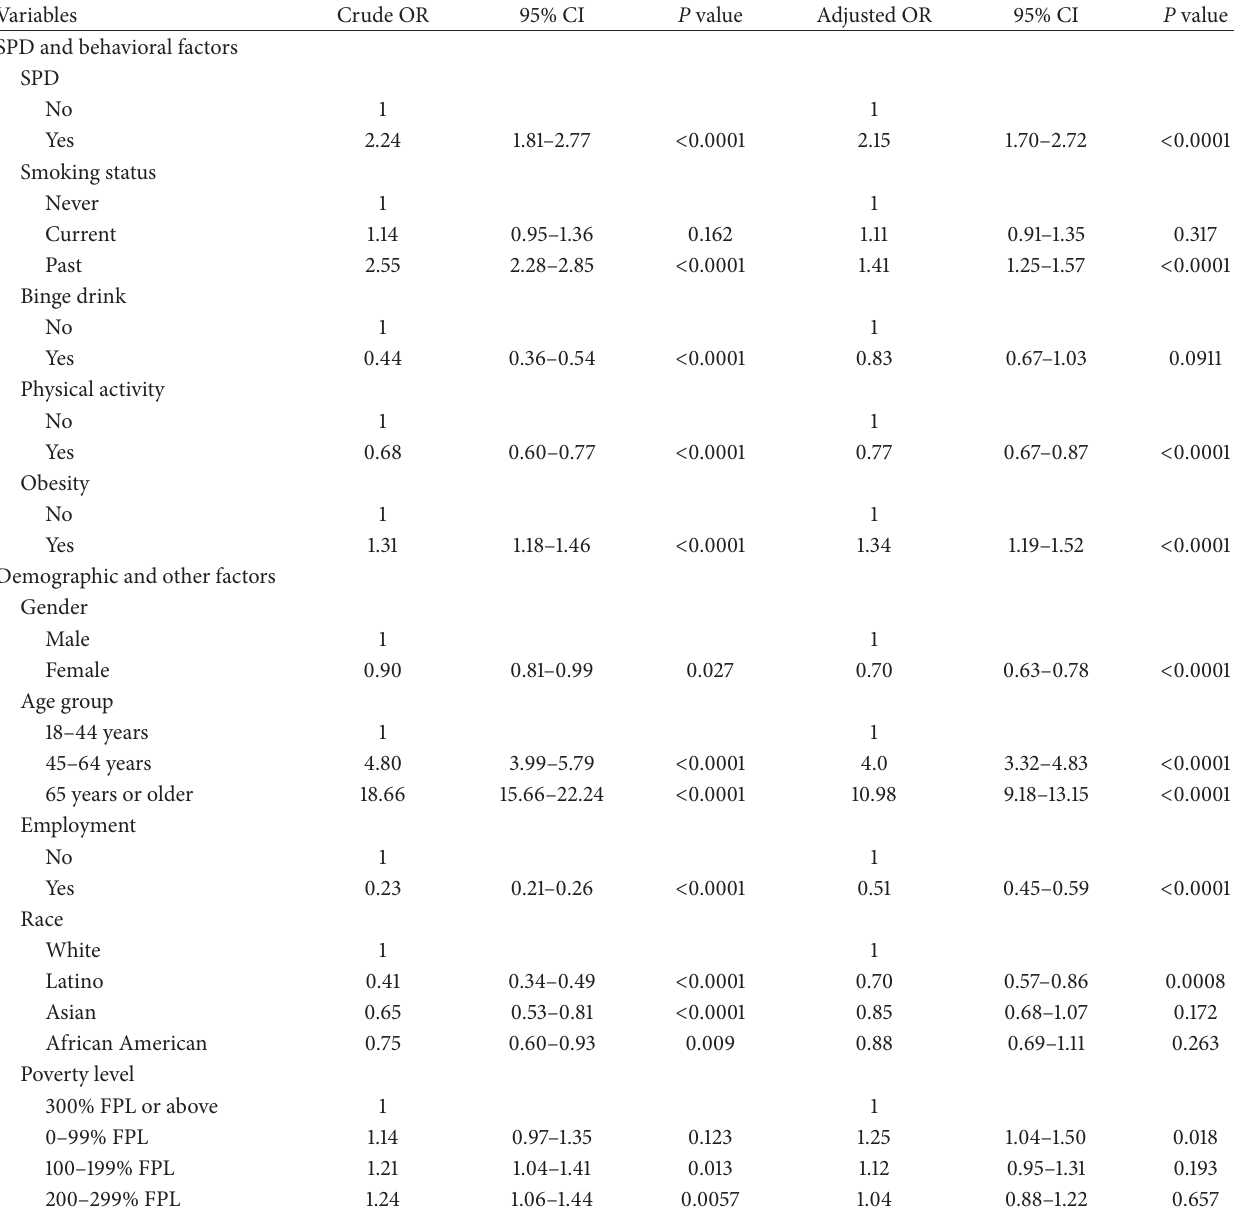
Table 2: Univariate and multiple logistic regression analyses for the relationship between all potential risk factors and heart